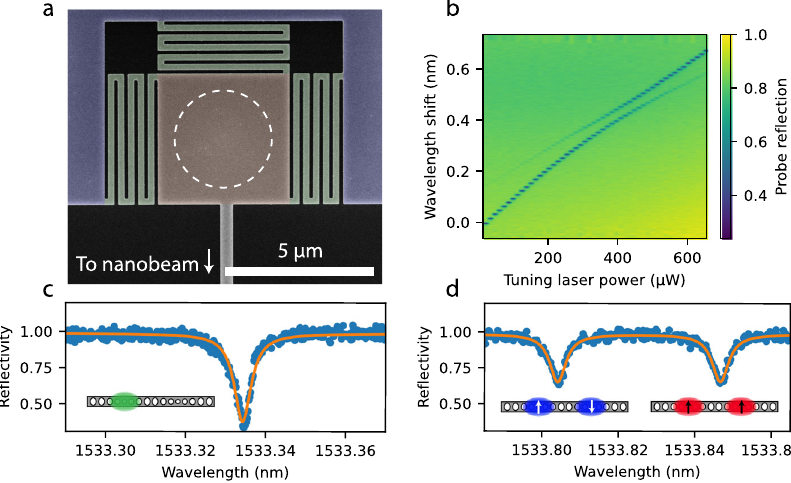
Fig.2|Thermaltuningoftheopticalmodesforfrequencymatchingofcoupled modes. a False-coloured scanning electron microscope image of the thermally- optimised tuning structure connecting device (bottom) and substrate (top, pur- ple). The meandering tethers (green) limit the fl ow into the substrate of heat generated by the green laser that is focused on the pad (orange, white circle indi- cationoflaserfocusscale). b SpectrogramofIRprobere fl ectionforvaryingpower